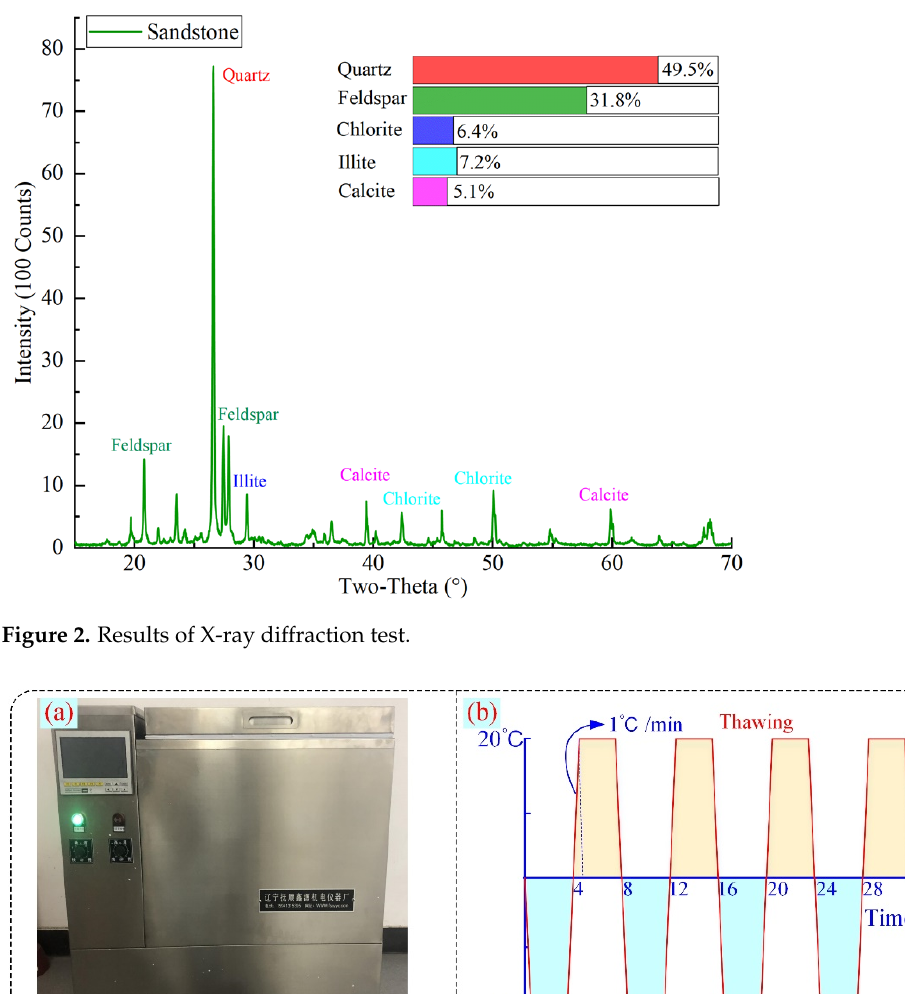
Figure 1. Diagram of static and dynamic samples.